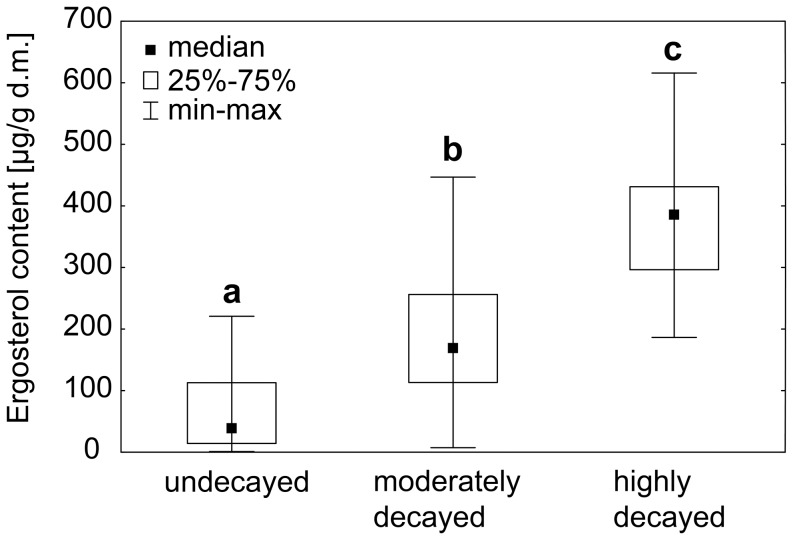
Changes in the concentration of ergosterol in dead wood along the decay gradient.Boxes bearing different letters denote significant differences in ergosterol content (Kruskal-Wallis test, p<0.05).